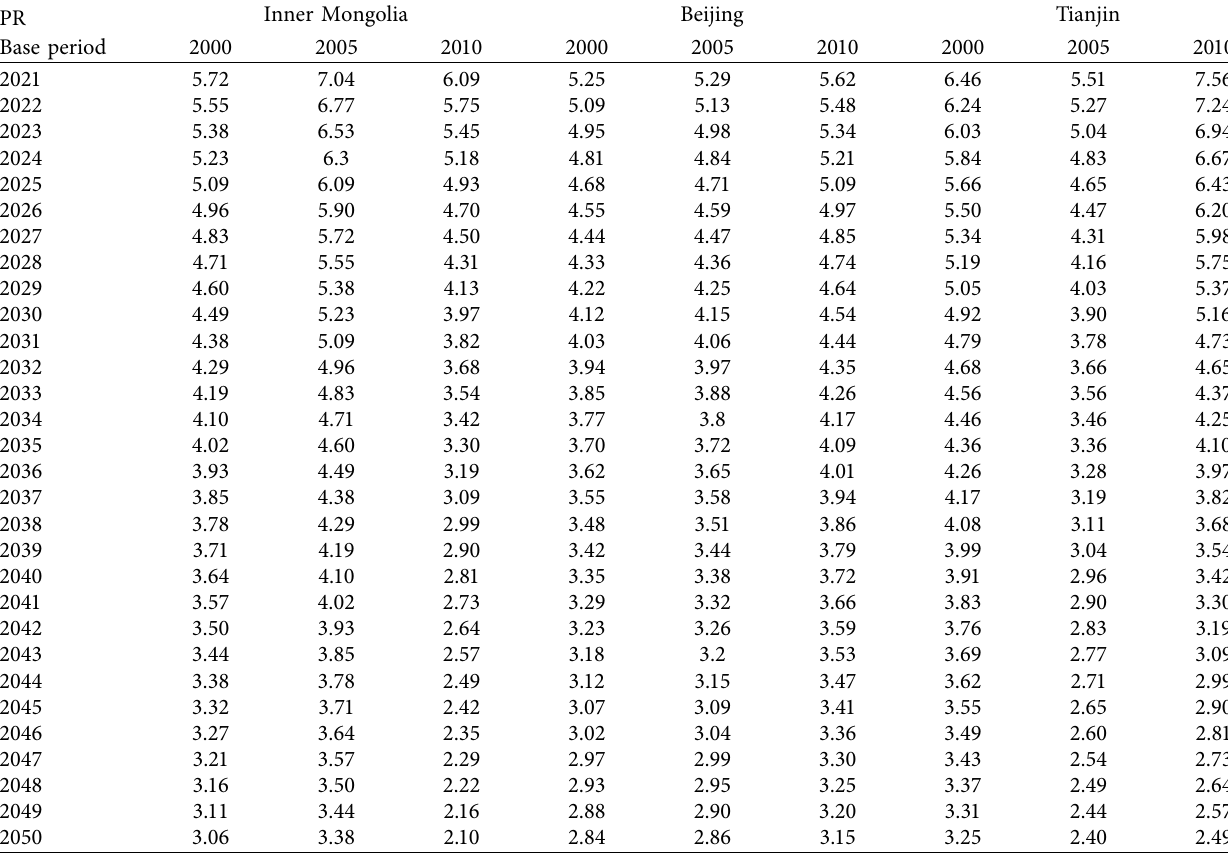
Table 2: Prediction of annual growth rate of GDP of Inner Mongolia, Beijing, Tianjin from 2021 to 2050 (unit: %). PR Inner Mongolia